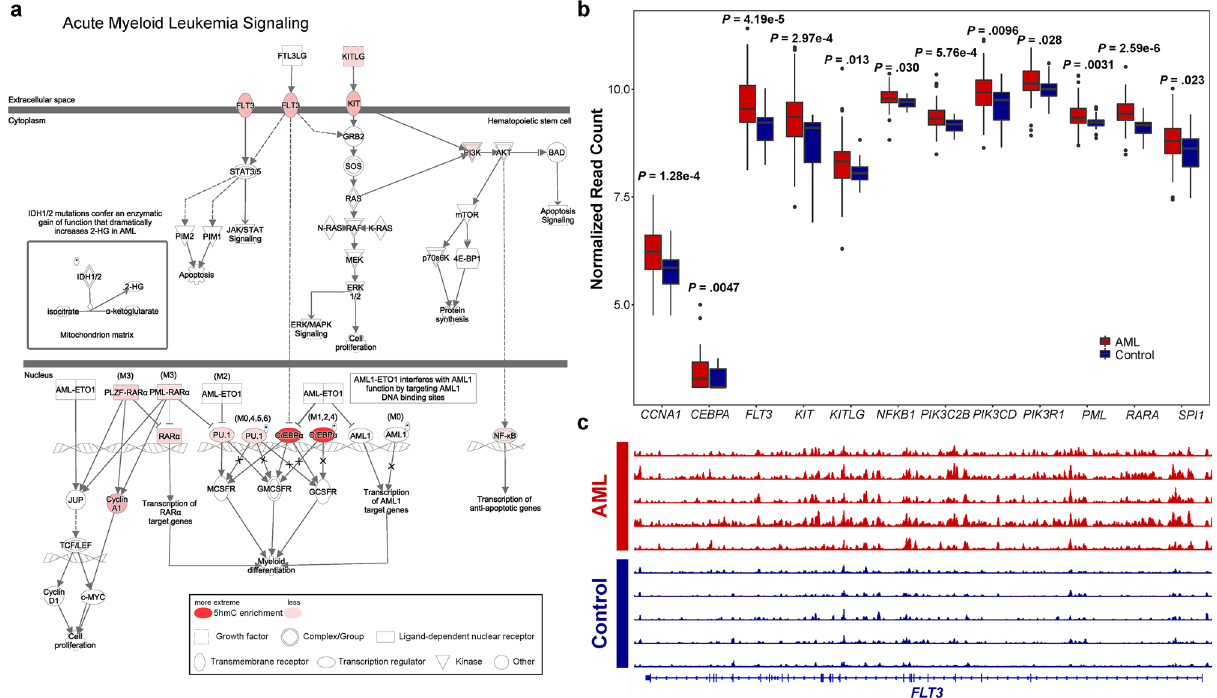
Figure 1. Differentially hydroxymethylated genes (DhMGs) involved in AML signaling pathways. ( a ) AML signaling pathways generated by IPA. ( b ) 5hmC levels in DhMGs associated with AML signaling. The DhMGs in AML signaling pathways are all enriched with 5hmC compared to controls (FDR < 0.01). Center line represents median, bounds of box represent 25th and 75th percentiles, and whiskers are Tukey whiskers. ( c ) Genome browser view of 5hmC distribution of FLT3 in AML and control samples. Peak height represents 5hmC